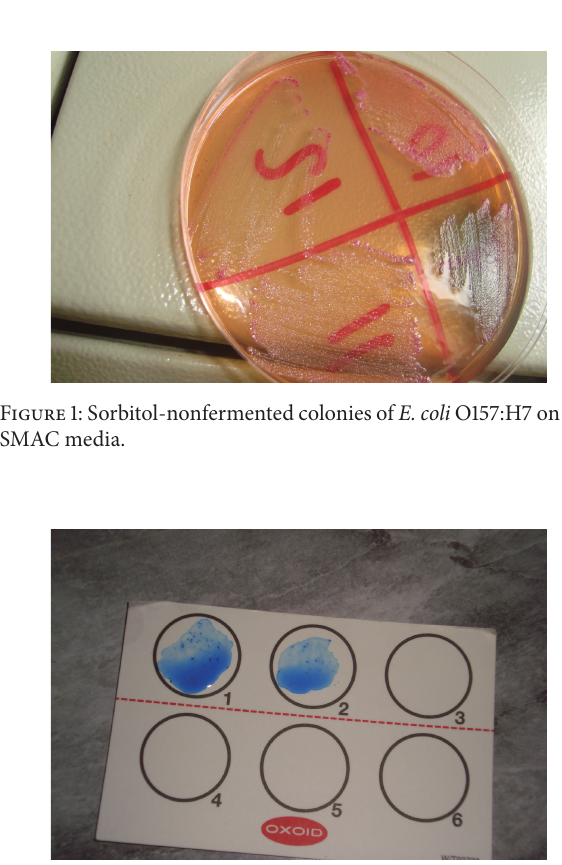
Figure 2: Agglutination of E. coli O157 and H7 latex reagent with isolates colonies of nonsorbitol-fermenting colonies on CT-SMAC